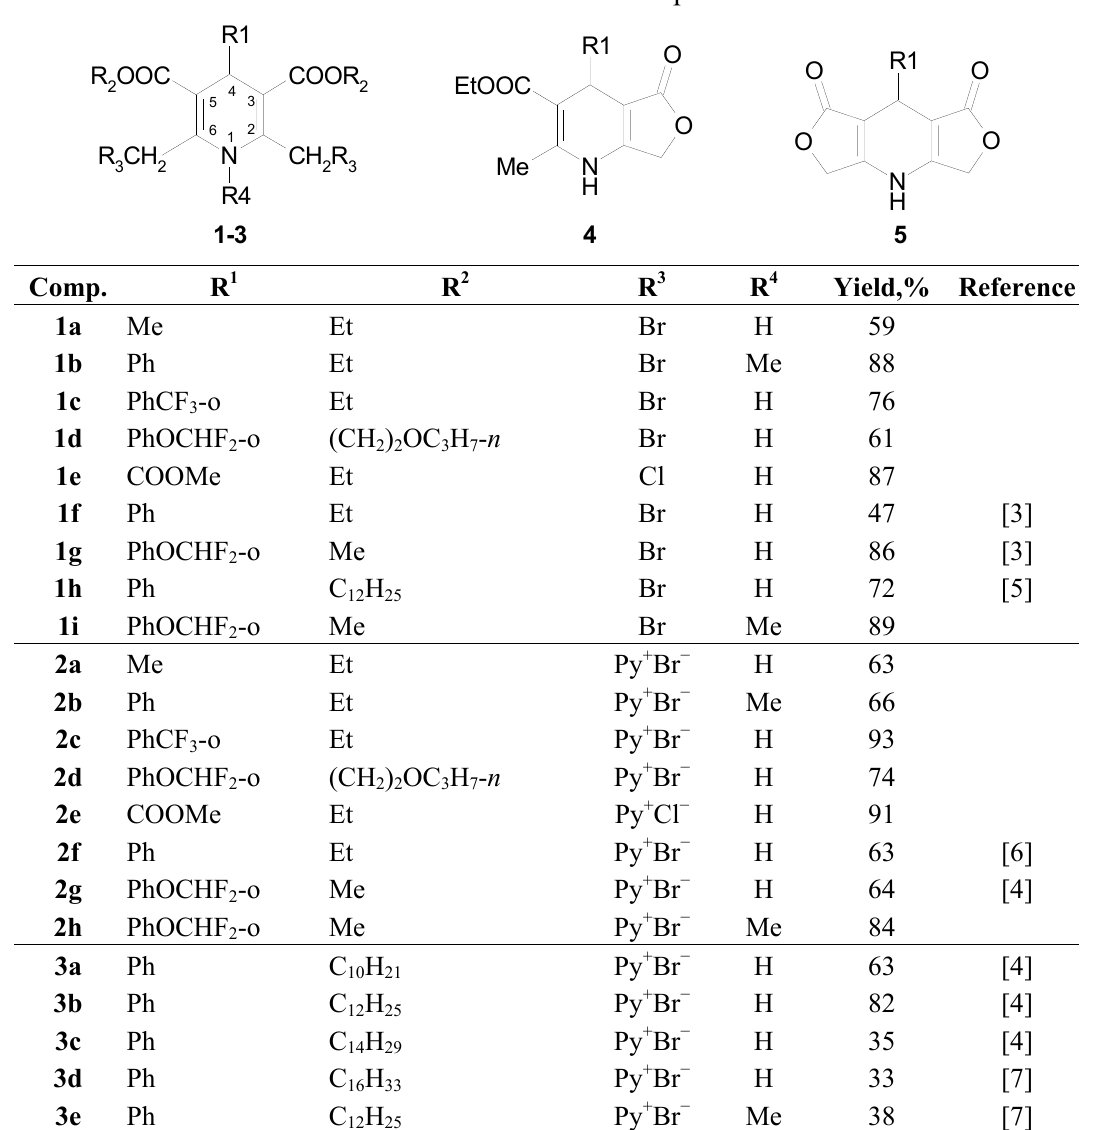
Table 1. Characterization of compounds 1–5